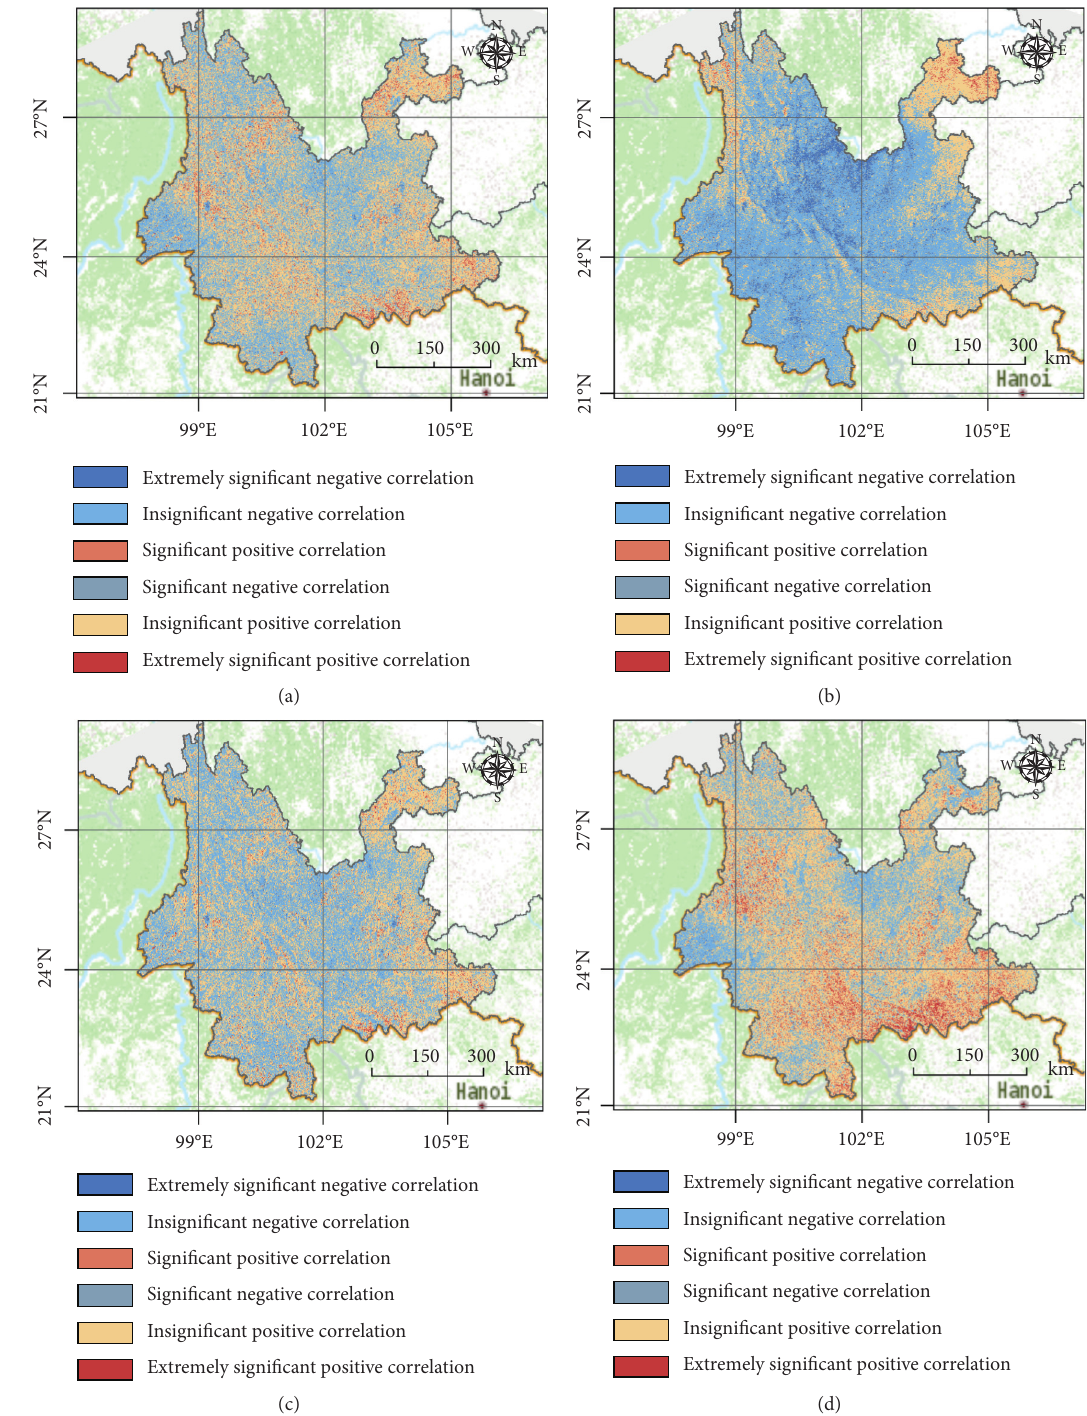
Figure 9: Spatial distributions of correlation coefficients between NDVI and temperature during different seasons. (a) Growing season; (b) spring; (c) summer; (d) autumn. (a)–(d) represent the proportion of correlation coefficient